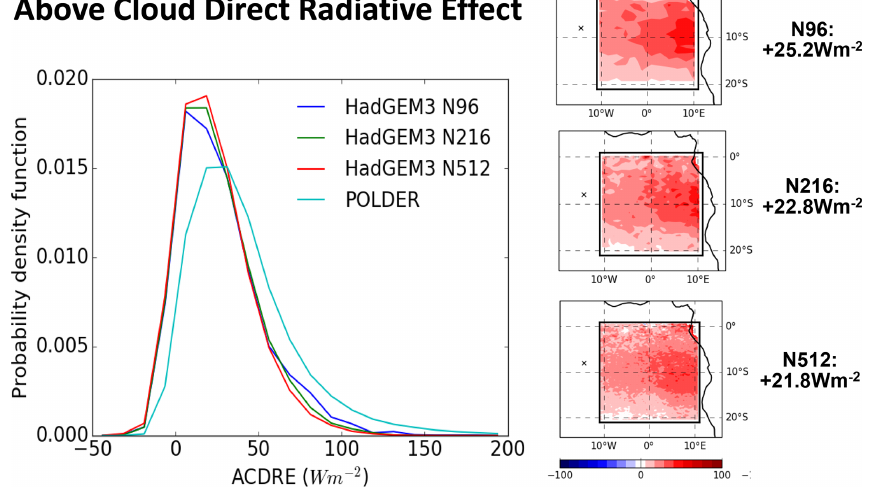
Figure 18. The above-cloud direct radiative effect diagnosed from the Unified Model (N96, N216, and N512 resolution, approximately 140, 60, and 25km respectively) over the area shown in the panels in the right-hand column. The probability density function of the above-cloud direct radiative effect is also shown from POLDER according to Peers et al. (2016). The intercomparison is for August–September 2006, and model data are matched to instantaneous POLDER